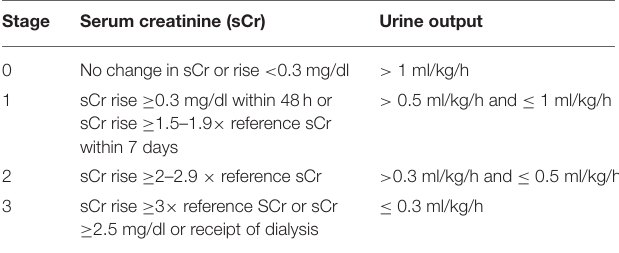
TABLE 2 | Acute kidney injury KDIGO classification modified for neonates (9,